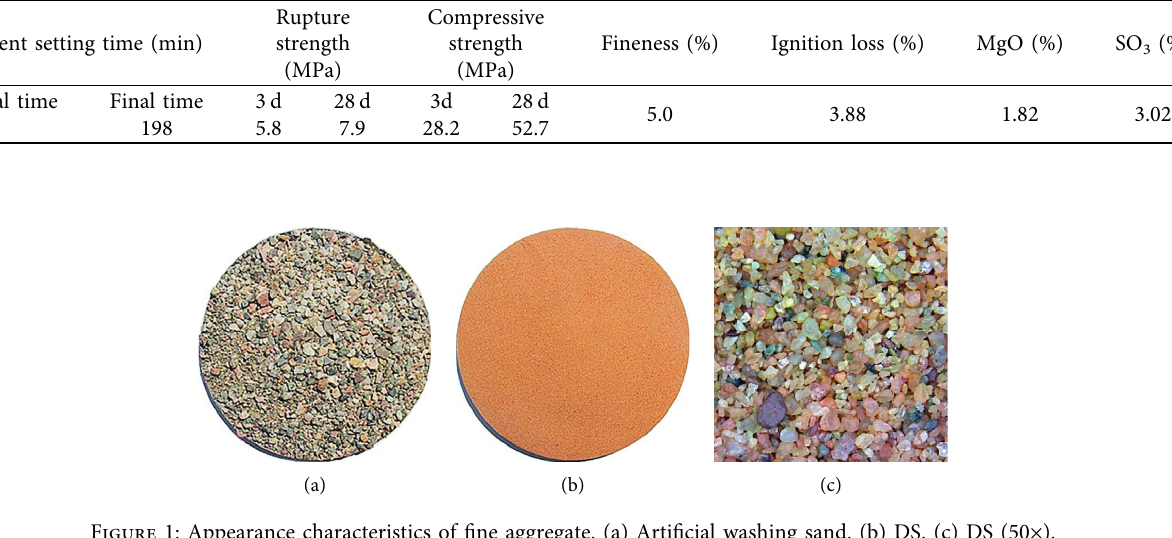
Table 1: Basic performance indexes of cement.